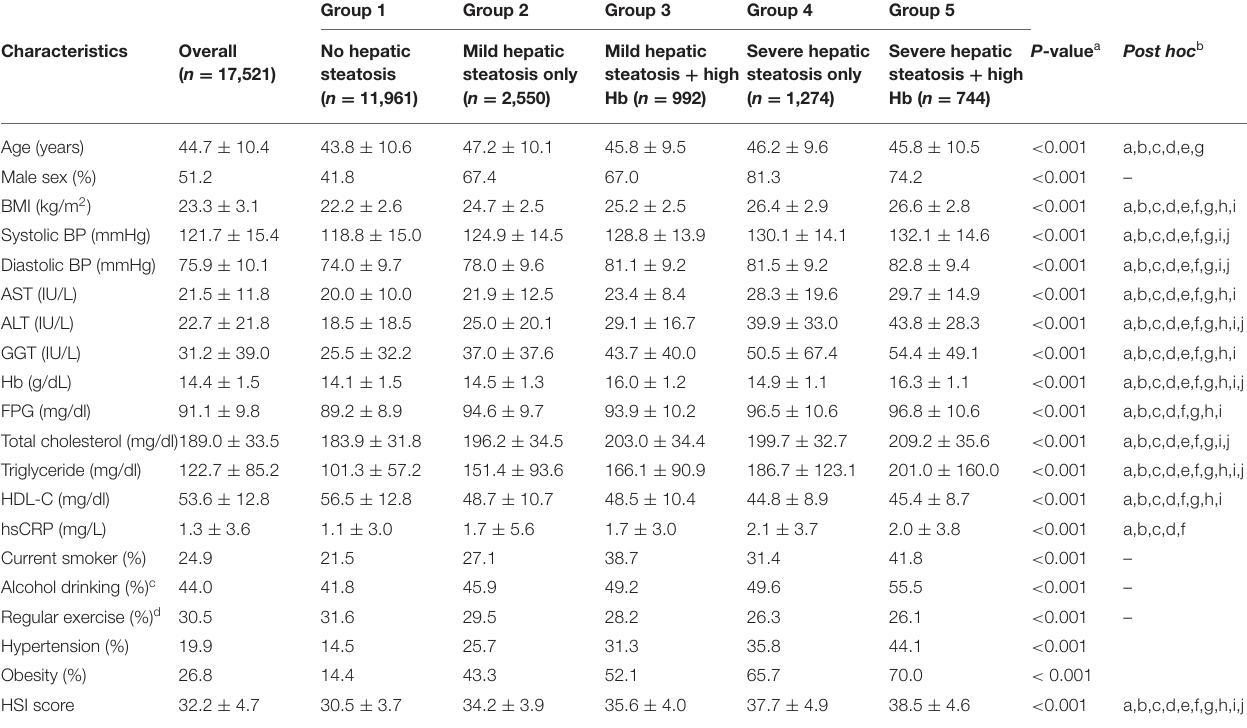
TABLE 1 | Baseline characteristics of the study population. Group 1 Group 2 Group 3 Group 4 Group